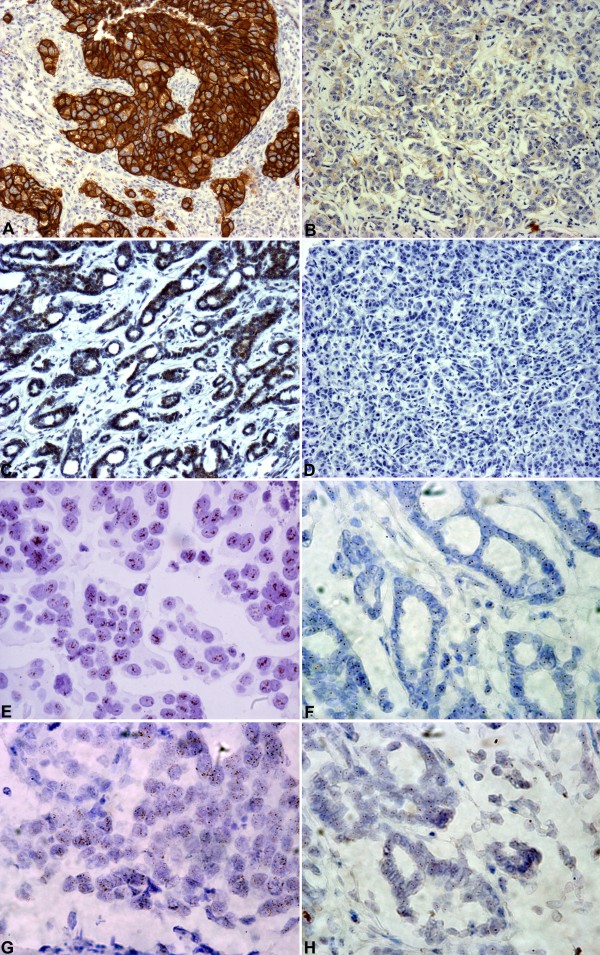
Representative examples of HER2 and TopoIIa protein expression and corresponding gene status. A-D: immunohistochemistry at a magnification of 100Χ (A: HER2 3+, B: HER2 0, C: TopoIIa positive and D: TopoIIa negative). E-H: CISH at a magnification of 600Χ (E: HER2 positive/amplified, F: HER2 negative/diploid, G: TOP2A positive and H: TOP2A negative).